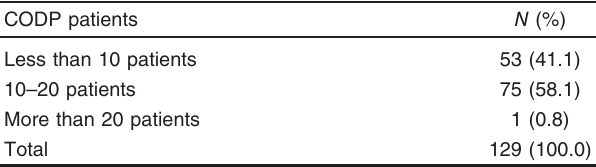
Table 7 Description of doctors according to number of chronic obstructive pulmonary disease patients who